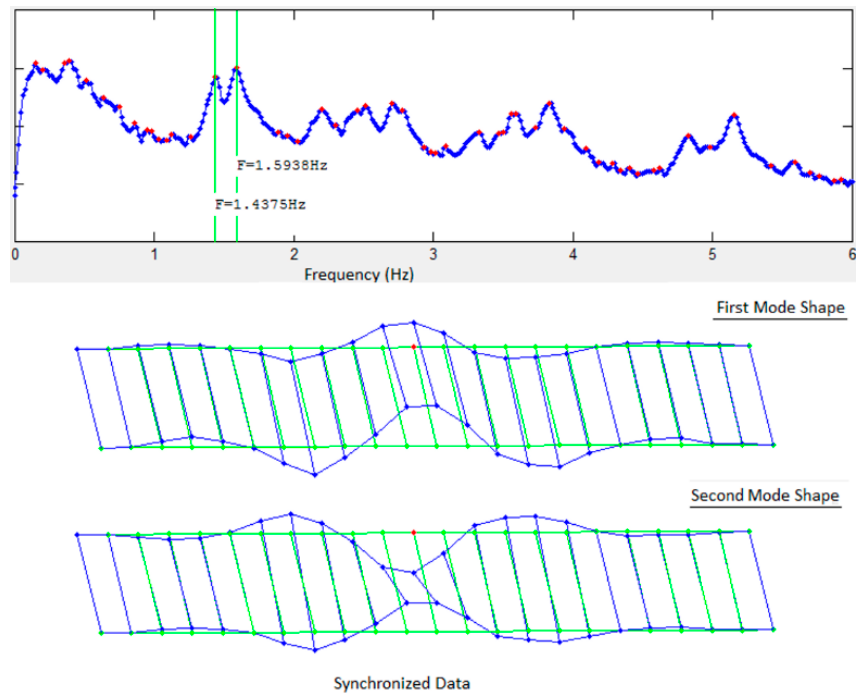
Figure 3. Singular value plots and first two mode shapes for synchronized data.